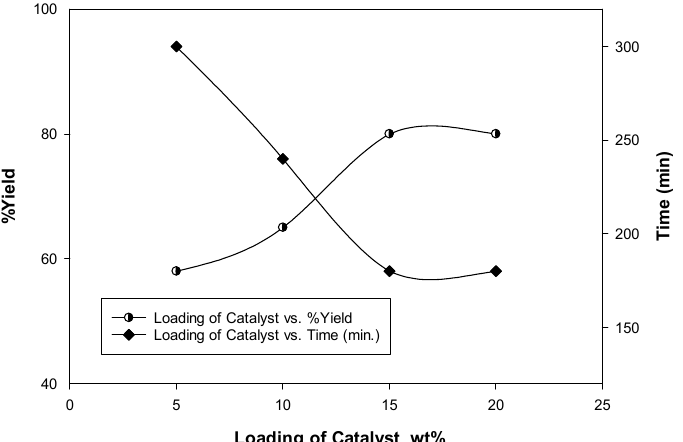
Figure 5. Henry reaction of benzaldehyde and nitromethane catalyzed by CS-CuO: Optimization of catalyst loading (wt.%). Experimental conditions: catalyst CS-CuO (wt.% = 5–20), solvent = EtOH-H 2 O (1:5), T = 120 °C, and reaction time = 3 h.